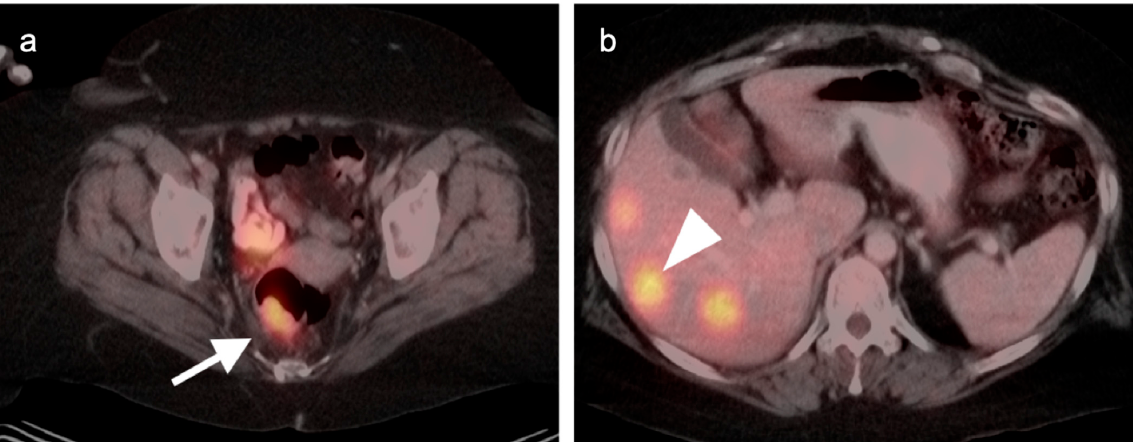
Figure 31. Rectal carcinoma with hepatic metastases, ( a ) Axial fused PET-CT image of the pelvis shows a hypermetabolic rectal mass (white arrow); ( b ) Axial fused PET-CT image of the upper abdomen shows multiple hypermetabolic liver metastases (white arrowhead). Typically, both primary colorectal carcinomas and their metastases are intensely hypermetabolic, although mucinous tumors can be low in activity.